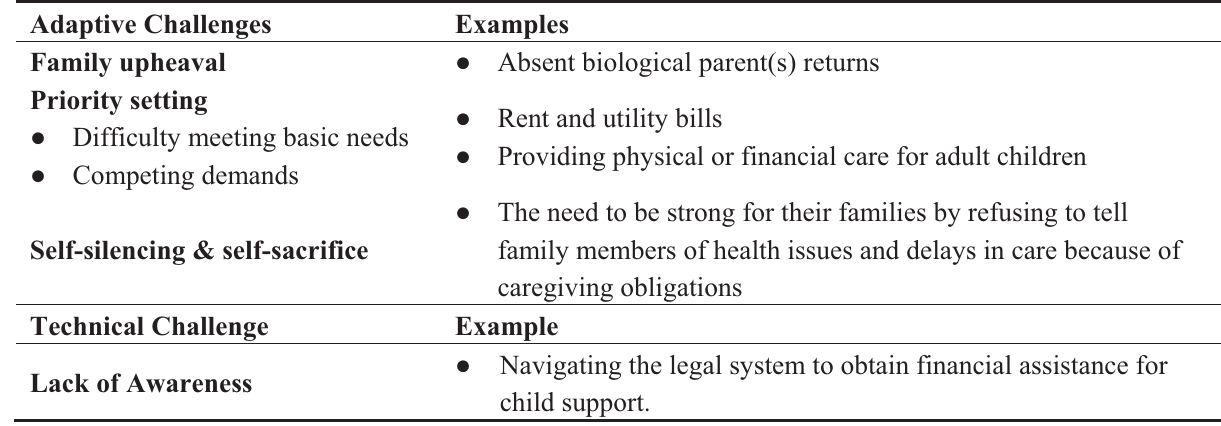
Table 4. Identified adaptive and technical